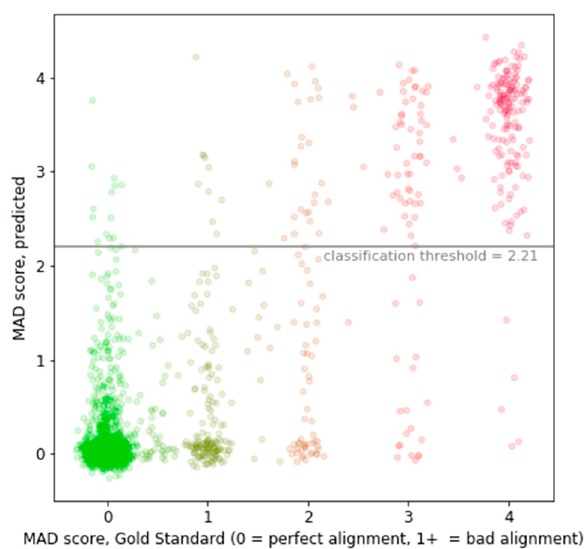
Figure 6. Gold Standard MAD score versus predicted MAD score for sentence pairs in the held-out test set.